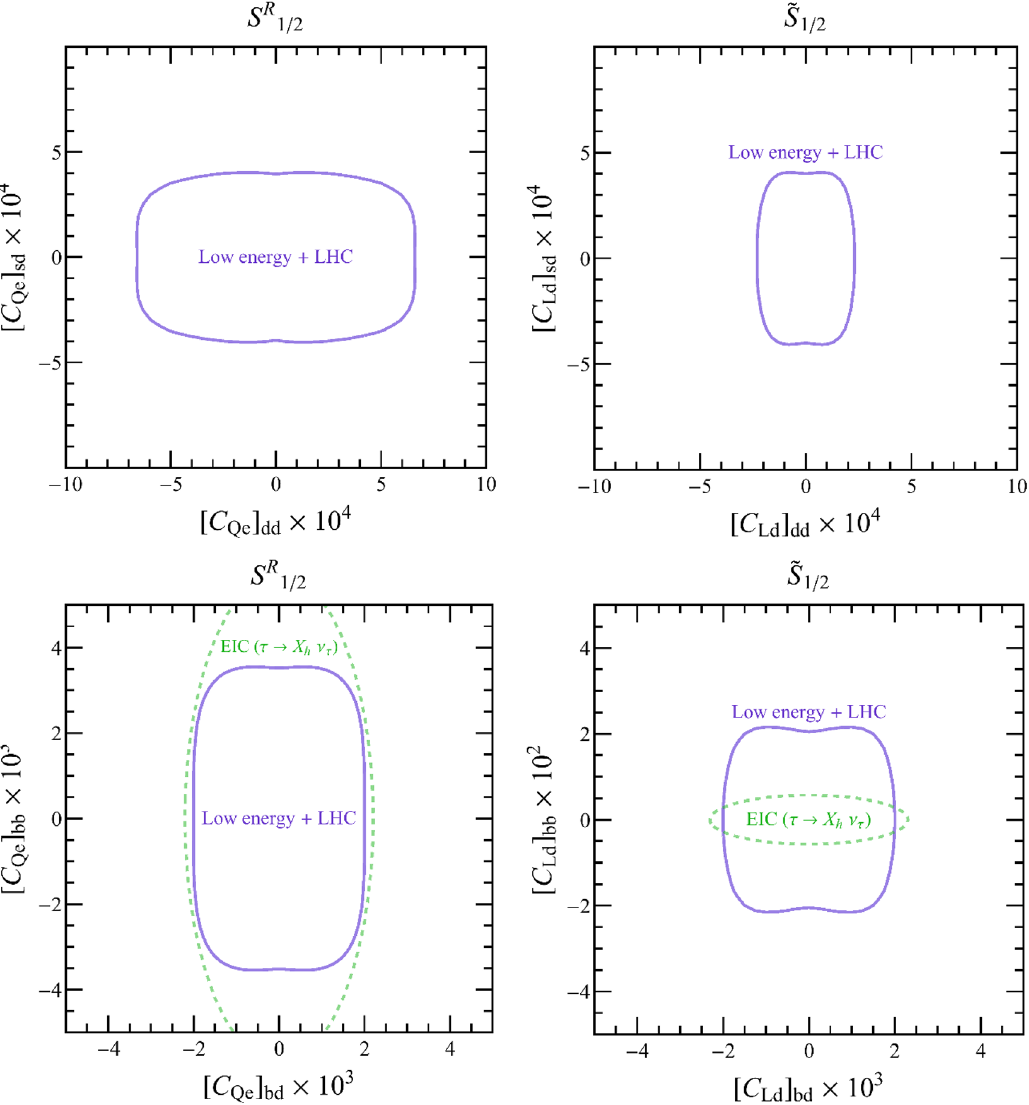
Figure 25 . [Upper] the contour that satisfies ∆ χ 2 < 2 . 71 in [ C Qe ] dd − [ C Qe ] sd (left) and [ C Ld ] dd − [ C ] (right) planes. [Lower] the same contour as the top two panels but in [ C Ld sd and [ C ] [ C ] (right) planes. Current limits from low-energy experiments and the LHC are Ld bd − Ld bb depicted by the purple contour. The EIC expected sensitivity in hadronic τ decays is described by the dashed green line under the assumption of n